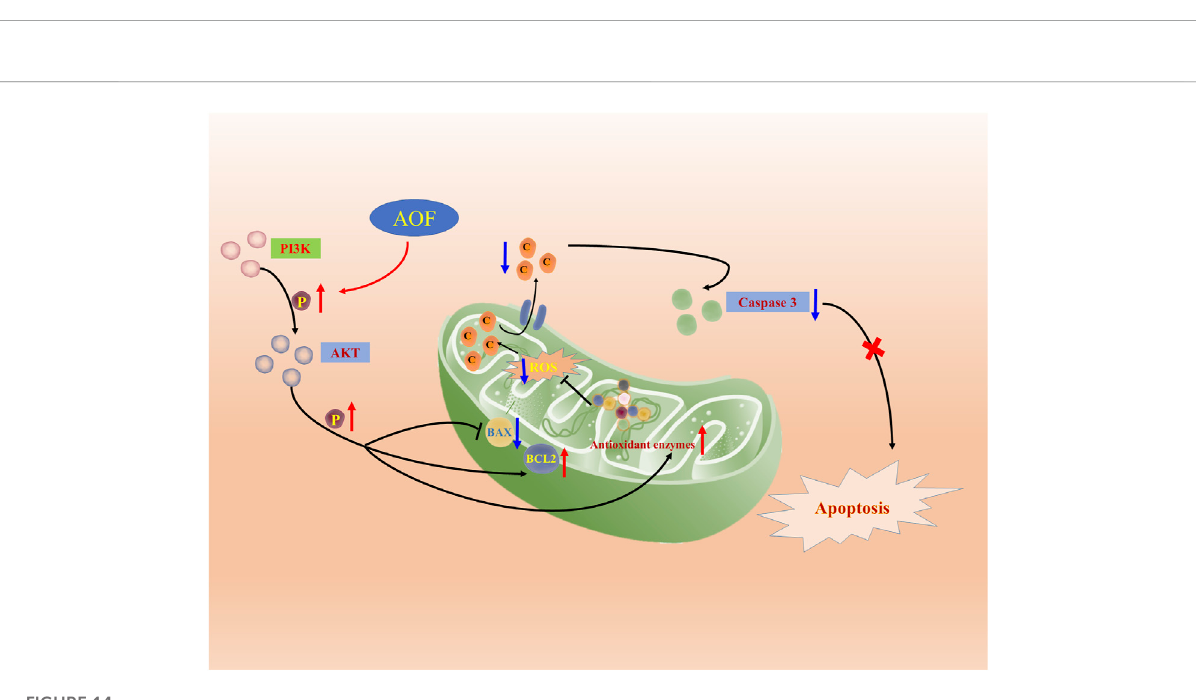
FIGURE 14 MolecularmechanismoftheprotectiveeffectofAOF.AOFpossessesprotectivepotentialsonH 2 O 2 -stimulatedPC12cellsthroughsuppression of oxidative stress-induced apoptosis via regulation of the PI3K/Akt signal